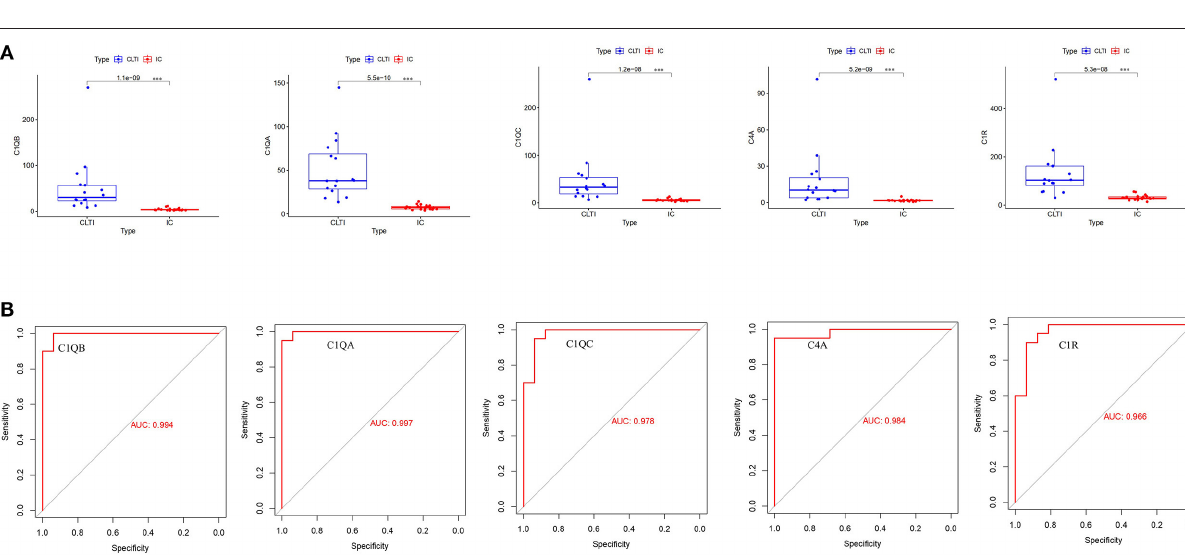
FIGURE 6 | Validation of hub gene expression in GSE120642. (A) We checked the expression of hub genes in GSE120642, and their boxplot showed that they all had higher expression in CLTI tissues (*** p < 0.001). (B) The receiver operating characteristic (ROC) curves of the hub genes were drawn to evaluate their accuracy in distinguishing IC and CLTI tissues. IC, intermittent claudication; CLTI, chronic limb-threatening ischemia; ROC, receiver operating